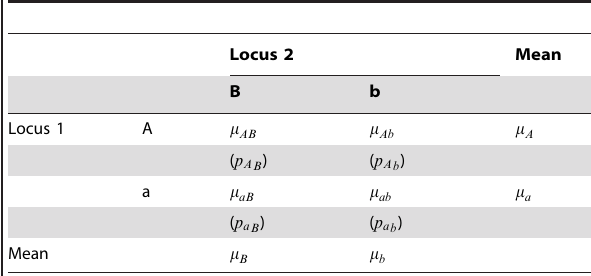
Table 2. Genotypic means and frequencies for a two-locus model used in the simulation studies.